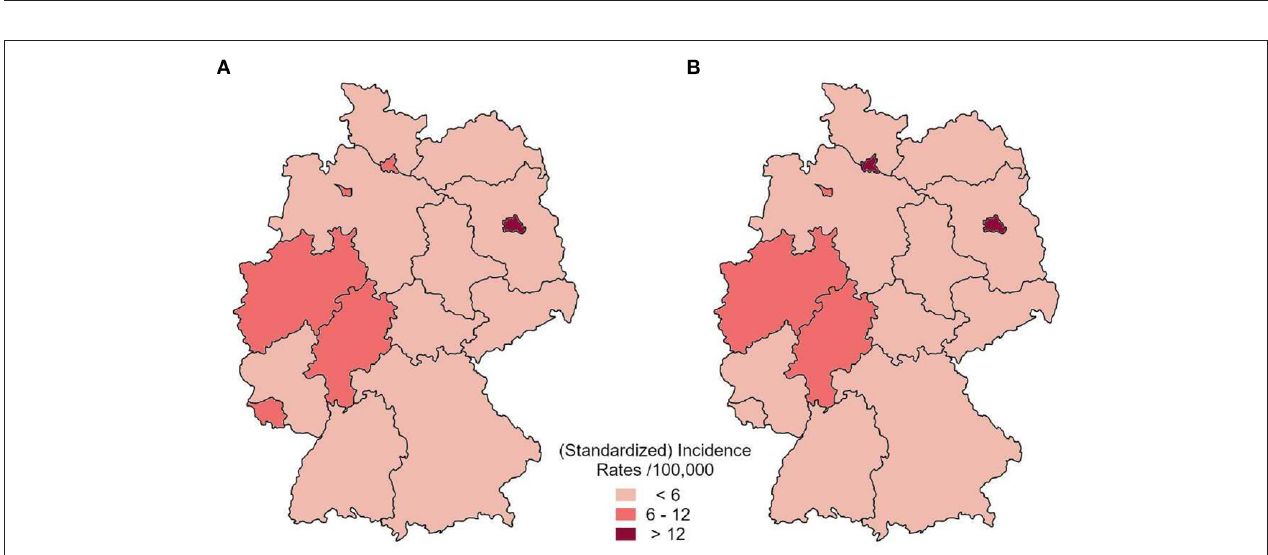
FIGURE 5 | Distribution of average annual standardized incidence by federal state based on the health insurance dataset (A) in comparison to reported incident cases to RKI (B) between 2010 and 2012.